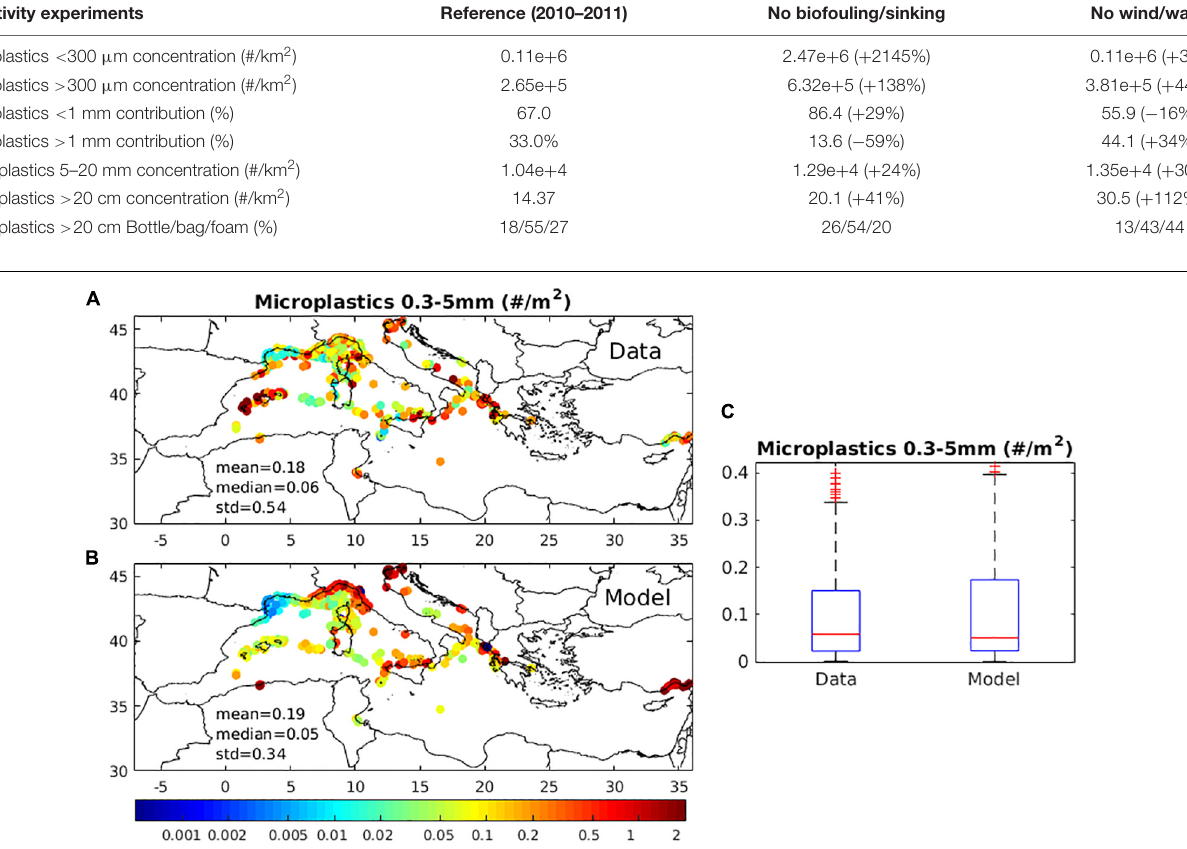
FIGURE 6 | Mean (2010–2017) (A) model simulated microplastics concentration (#/m 2 ), against (B) available in situ data (#/m 2 ) and (C) boxplot showing model and data range, with median and 25th/75th percentiles indicated. In situ data were obtained from: Collignon et al. (2012); Eriksen et al. (2014); Faure et al. (2015);